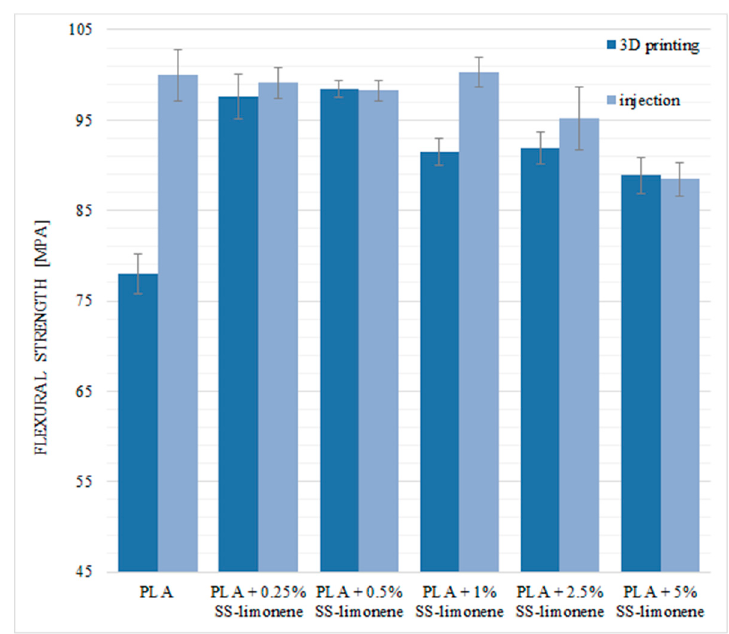
Figure 10. Flexural strength of SS-Limonene/PLA in 3D printing and injection moulding.